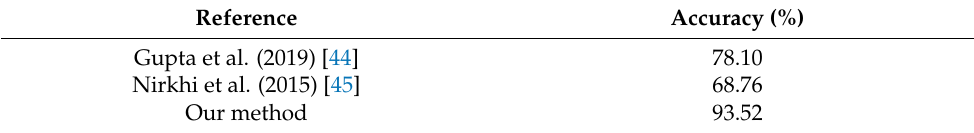
Table 13. The results obtained on the C50 dataset using the proposed